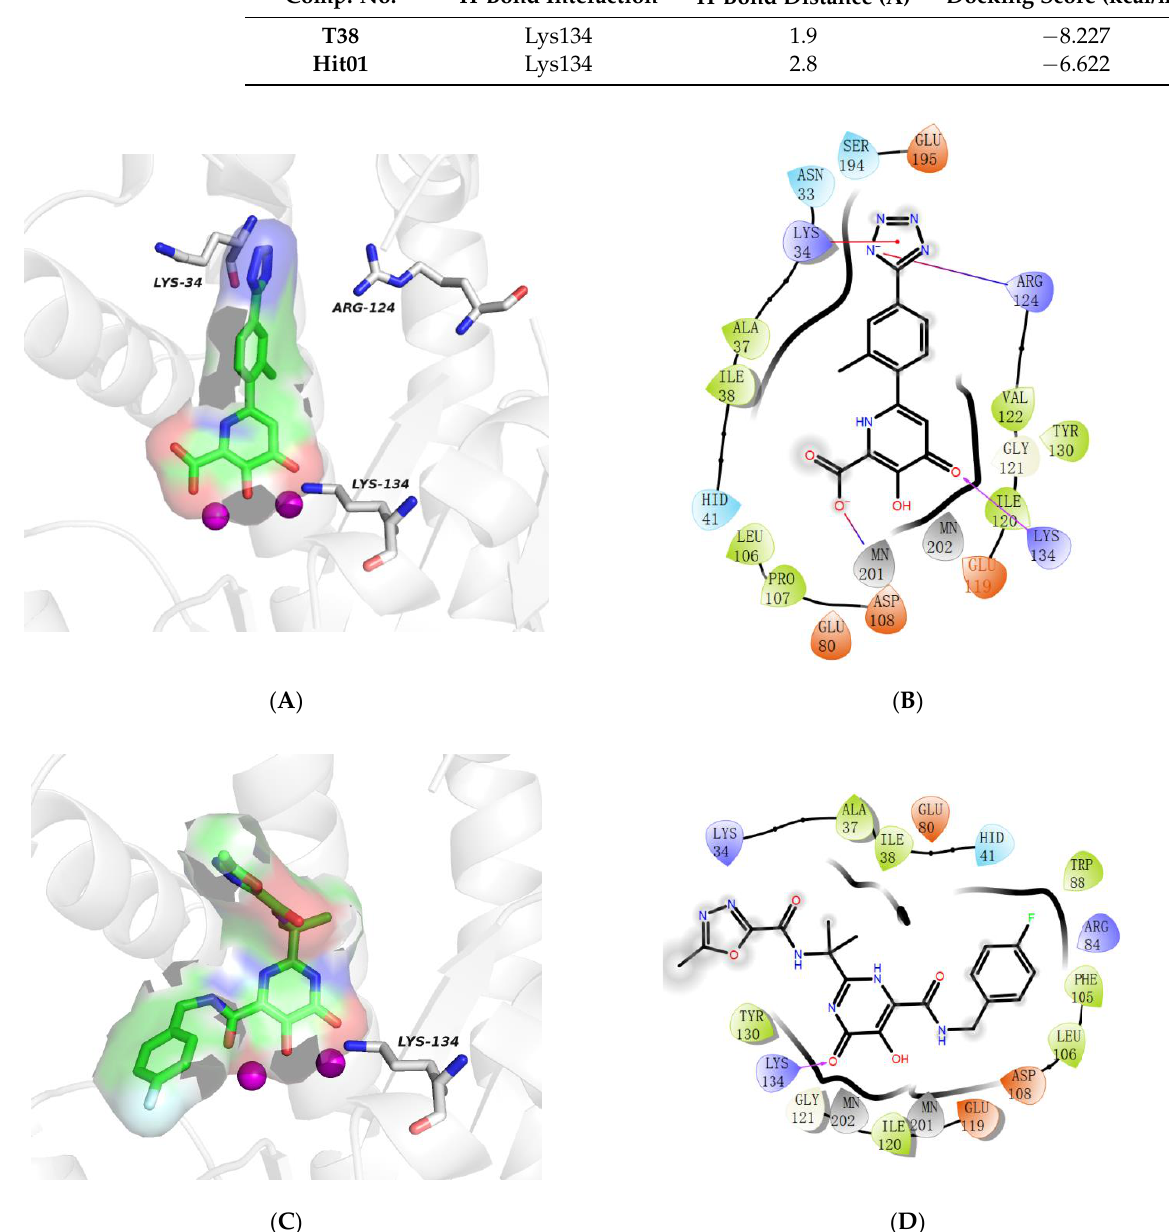
Table 6. Docking interactions of T38 and Hit01 with PA N endonuclease protein (PDB ID 6E6W). Comp. No.